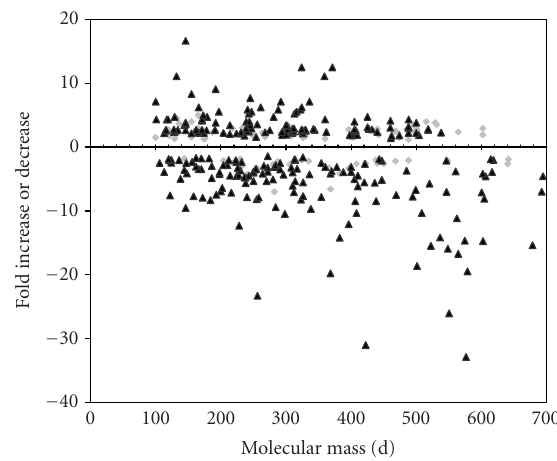
Figure 3. Scatter plot distribution of all classes of metabolites identified in root